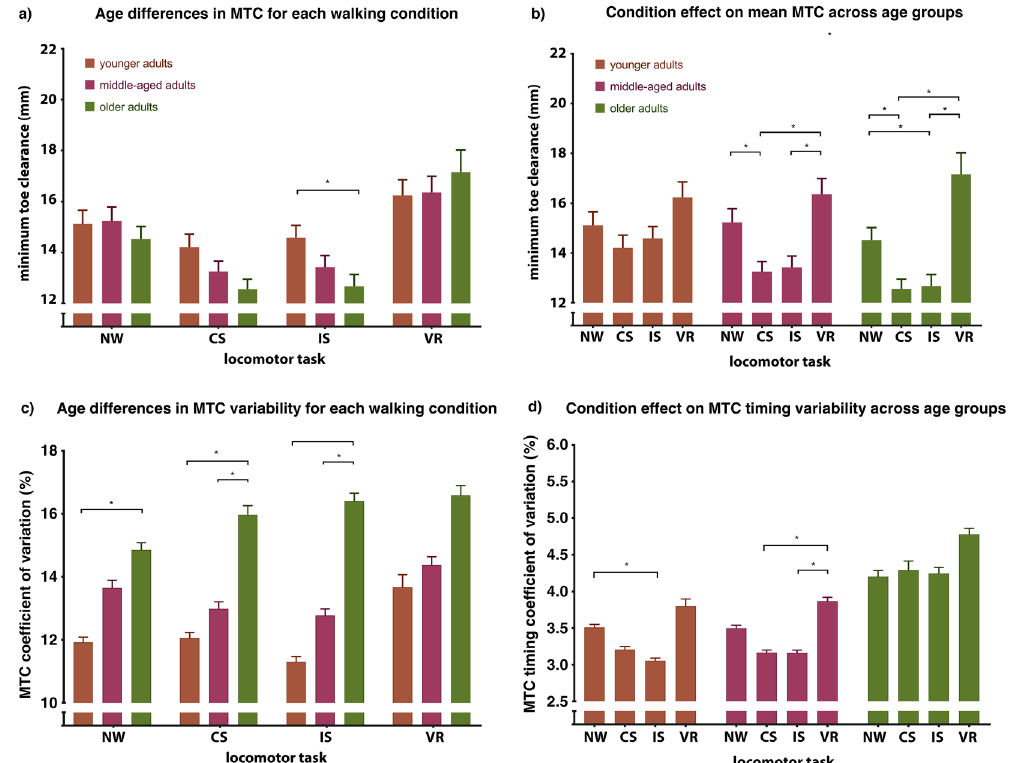
Figure 2. Minimum toe clearance parameters under different locomotor conditions. ( a ) The effect of age group on MTC in each of the four walking conditions. Differences in mean MTC between age groups (younger adults; 20–39, middle-aged adults; 40–59, older adults; 60–80) tested using ANOVA and post-hoc t-tests where appropriate with significance set at p ≤ 0.05, corrected for multiple comparisons (Bonferroni). NW; normal walking, CS; congruent Stroop task, IS; incongruent Stroop task, VR; visual restriction. ( b ) Within- age group condition effects on mean MTC, compared using a linear mixed model (see methods) and post-hoc t-tests where appropriate with significance set at p ≤ 0.05, corrected for multiple comparisons (Bonferroni). ( c ) Differences in mean MTC variability (coefficient of variation; CoV) between age groups, compared using ANOVA as in (a). ( d ) Condition effect on MTC timing variability (CoV), compared using a linear mixed model as in b). Error bars indicate